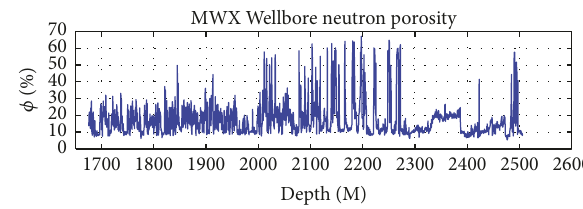
Figure 4: Neutron porosity wellbore log of MXW well between 1675 and 2520